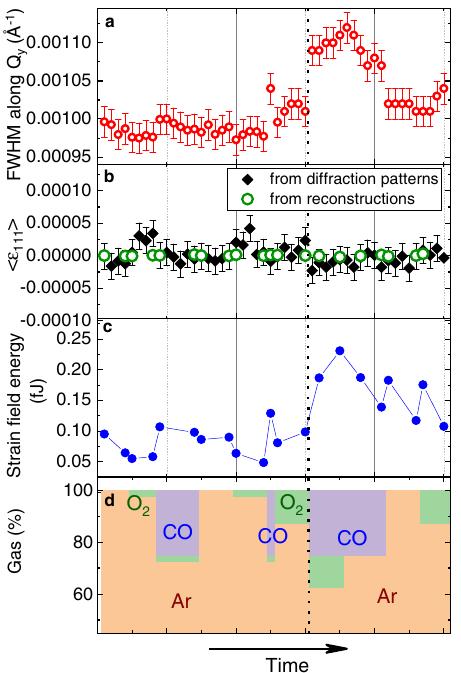
Fig. 3 In situ structural evolution of NP300 during reaction. Evolution of ( a ) the full width at half maximum (FWHM) of its diffraction pattern along the Q y direction, of ( b ) its average strain, 〈 ϵ 111 〉 calculated from the centre of mass of the diffraction patterns or from the reconstructed strain fi eld, of ( c ) its strain fi eld energy and of ( d ) the gas composition at the inlet (Ar, O 2 , and CO are in orange, green and purple, respectively) as a function of time. The dashed line indicates the beginning of the CO oxidation reaction under stoichiometric